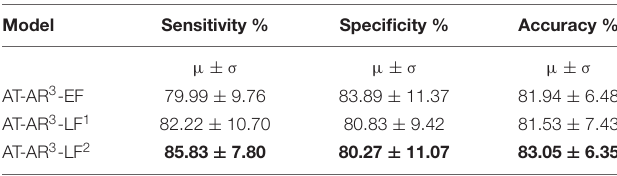
TABLE 3 | Channel classification performance parameters for different approaches using feature fusion from time and frequency domains (training paradigm-II).